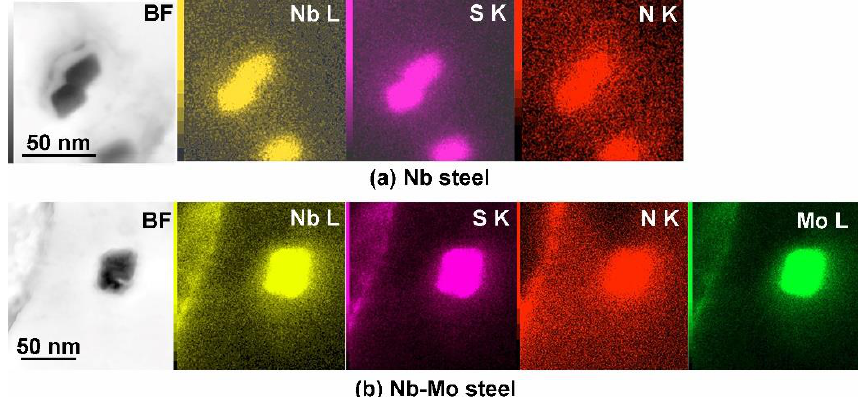
Figure 6. Bright-field (BF) TEM image and corresponding energy dispersive spectroscopy (EDS) chemical maps for the carbon replicas of precipitates in the ( a ) Nb and ( b ) Nb-Mo steels heat treated at 900 °C for 10,000 s.